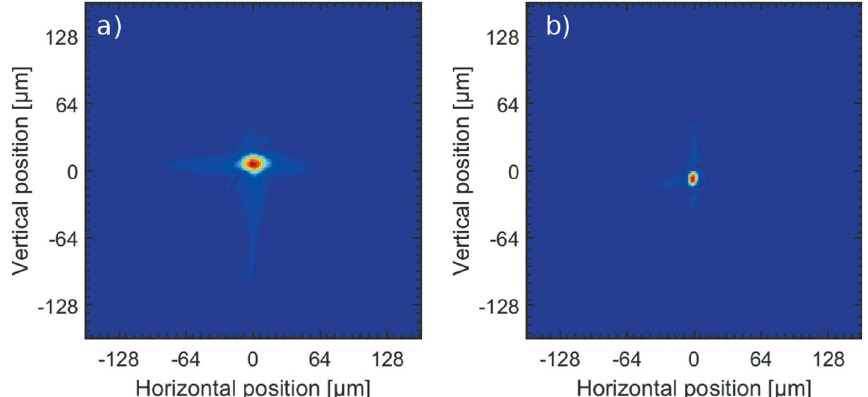
Figure 13 Beams in the focus position taken from backpropagation calculations with the Hartmann wavefront sensor at (cid:4) = 15 nm. The diameter of the spot size in the variable delay beam path ( a ) amounts to 19 m m (FWHM) and 14 m m (FWHM) at a focal length of 3.1 m and in the fixed delay beam path ( b ) amounts to 7 m m (FWHM) and 11 m m (FWHM) at a focal length of 3.2 m in the horizontal and (FWHM) in the horizontal and vertical vertical directions,